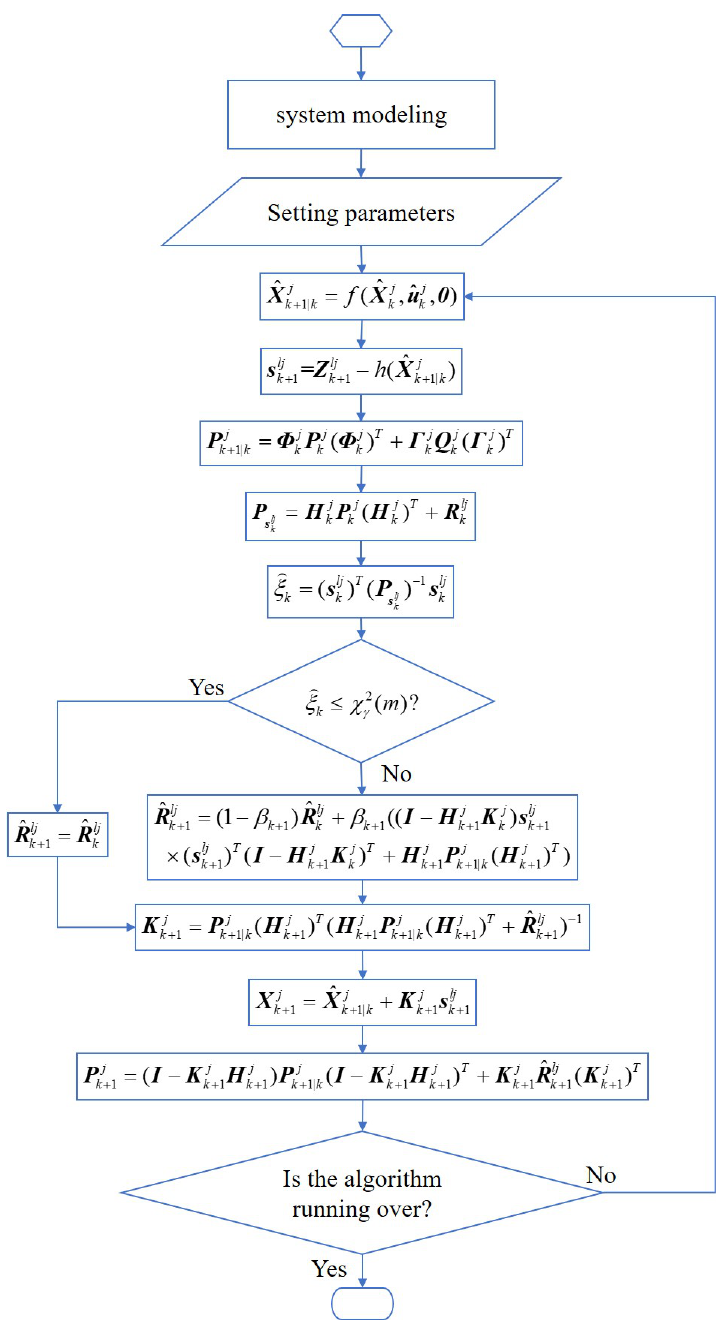
Figure 2. Flow diagram of the improved SHAEKF